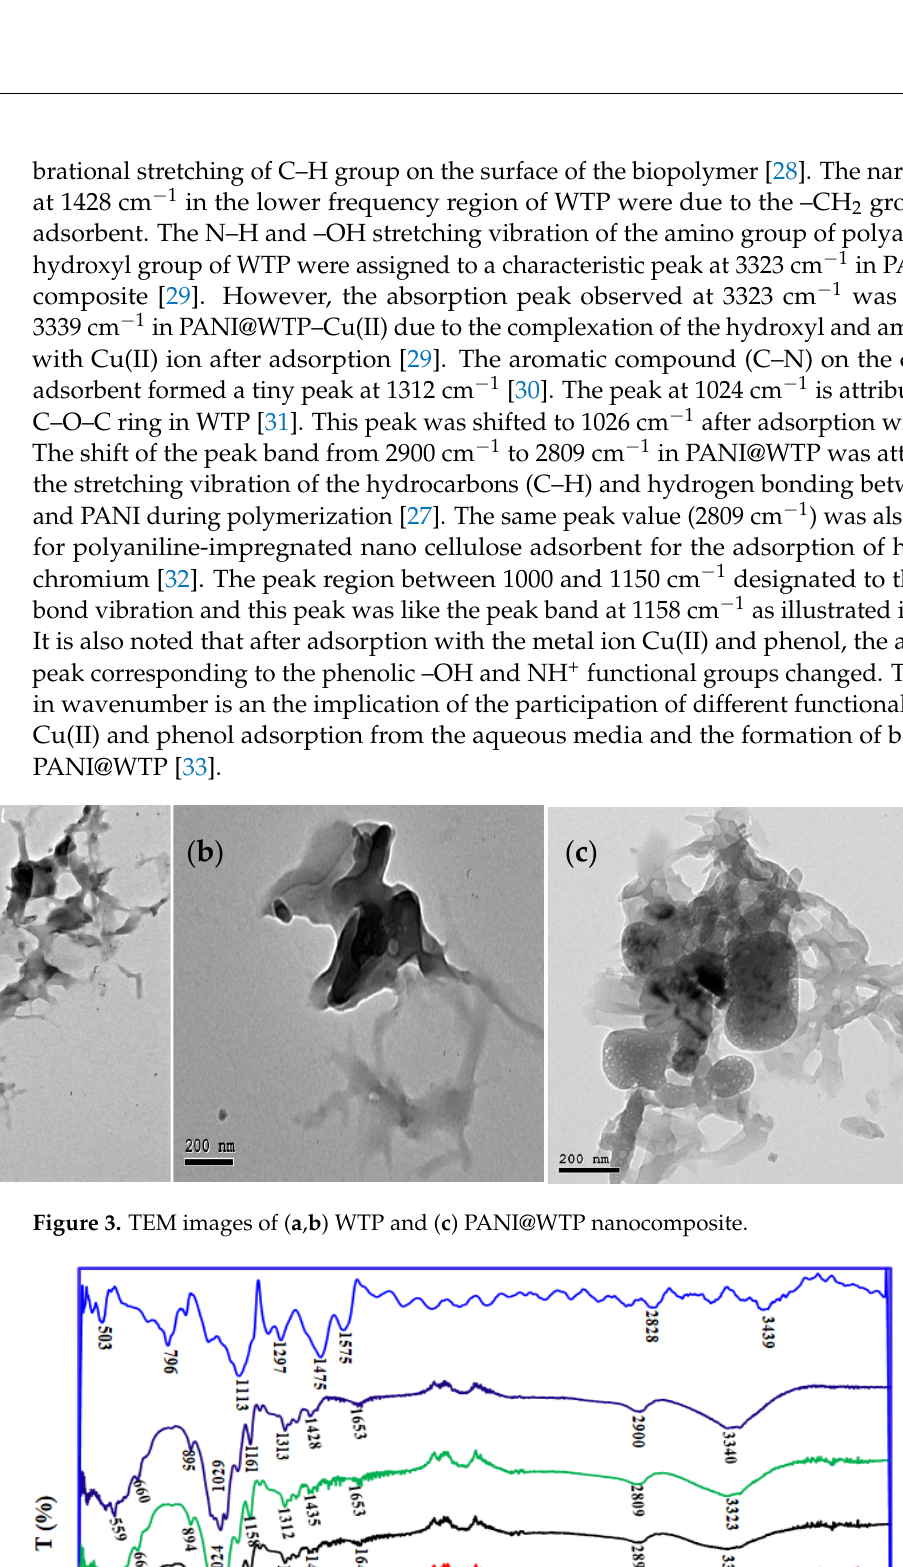
Figure 4. FTIR spectrum of WTP, PANI@WTP nanocomposite before and after pollutant